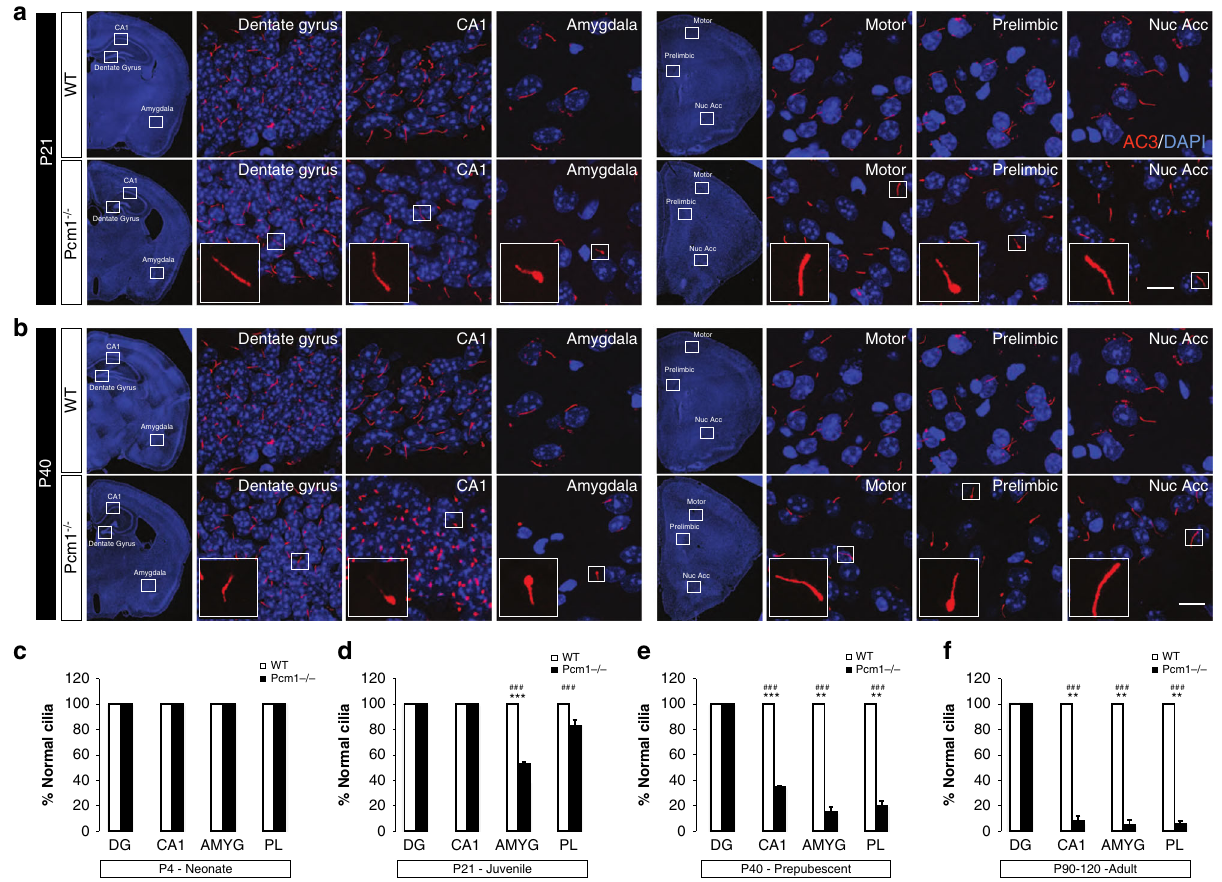
Fig. 3 Temporal and spatial ciliary abnormalities at different ages. a Coronal brain images revealing bulbous cilia in the prelimbic cortex and amygdala of P21 Pcm1 − / − mice. Scale 5 µ m ( b ) At P40, brain regions in the Pcm1 − / − mice showing an increased frequency of bulbous cilia. Scale 5 µ m ( c – f ) Bar graphs showing the proportion of normal cilia in various brain regions from P4 ( c ), P21 ( d ), P40 ( e ), and P90 ( f ) in WT and Pcm1 − / − mice ( c – f ; N > 30 cilia/ region/mouse, 3 mice/genotype; t -test p < 0.001 P21 AMYG; p < 0.001 P21 CA1; p = 0.004 P40 AMYG; p = 0.005 P40 PL; p = 0.004 P90 CA1; p = 0.003 P90 AMYG; p = 0.0012 P90 PL). DG dentate gyrus, AMY amygdala, PL prelimbic cortex. χ 2 test, ### p < 0.001; t -tests, mean ± SEM ** p < 0.01, *** p